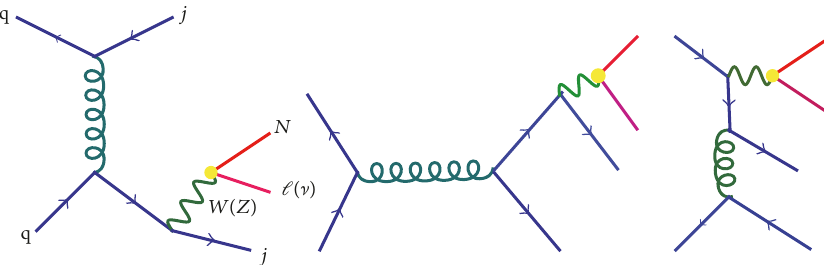
Figure 5: 2-jet process to produce 𝑁 with ℓ( ] ) in association with a jet from the CC(NC) interaction from qq 󸀠 ( qq ) initial state.